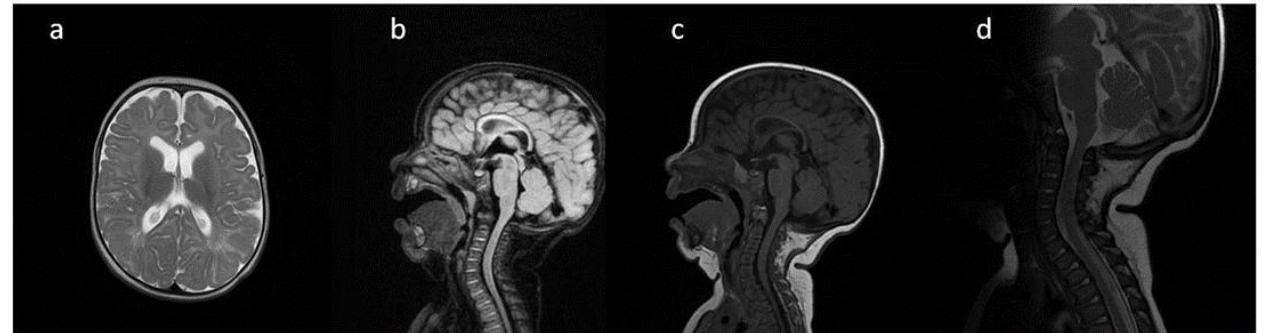
Table 5. Brain, head and spine. Radiological symptoms.